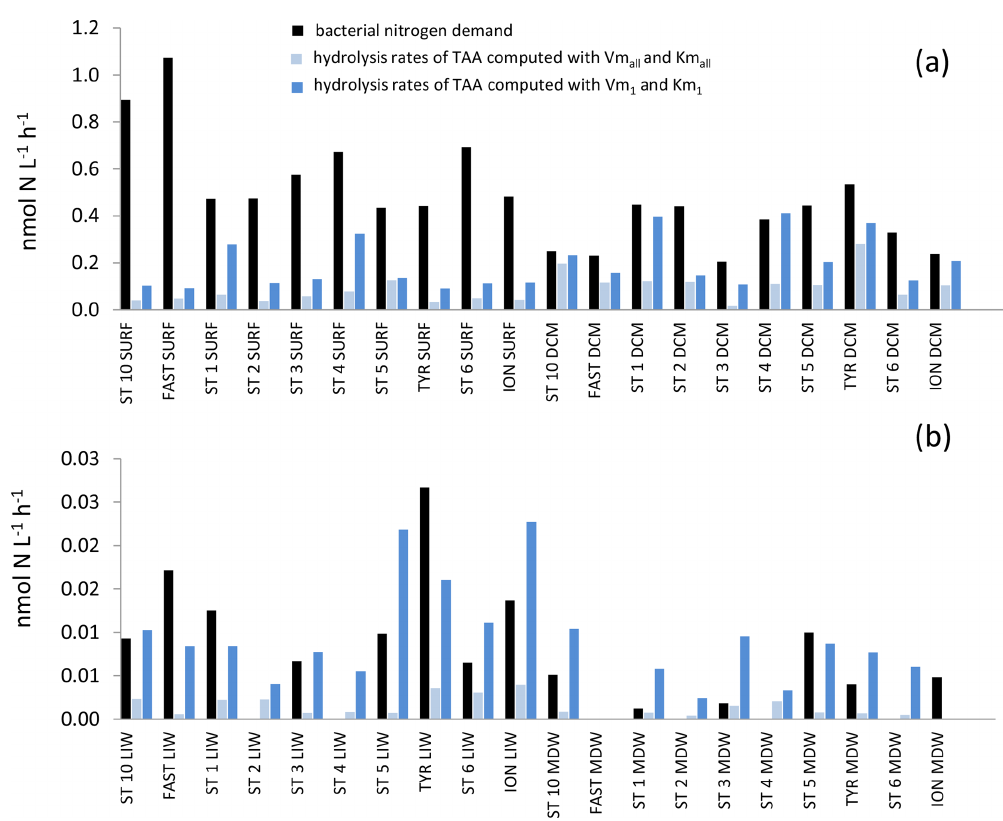
Figure 10. In situ hydrolysis rates of proteins (nmolNL − 1 h − 1 ), determined from TAA and LAP ectoenzyme kinetics for the high- and low- affinity systems, and heterotrophic bacterial nitrogen demand, determined from BP assuming a C / N molar ratio of 5 and no active excretion of nitrogen. (a) Epipelagic layers (SURF, DCM), (b) deeper layers (LIW,